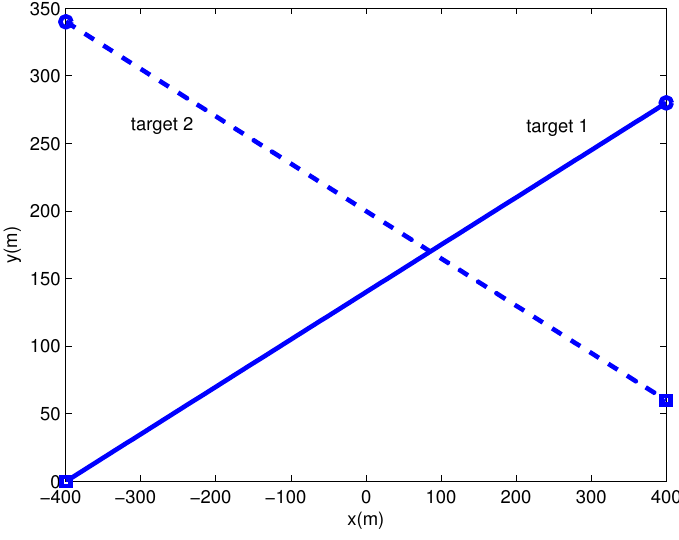
Figure 6. Trajectories of extended targets (’o’ is the start point, (cid:48) (cid:3) (cid:48) is the end point).